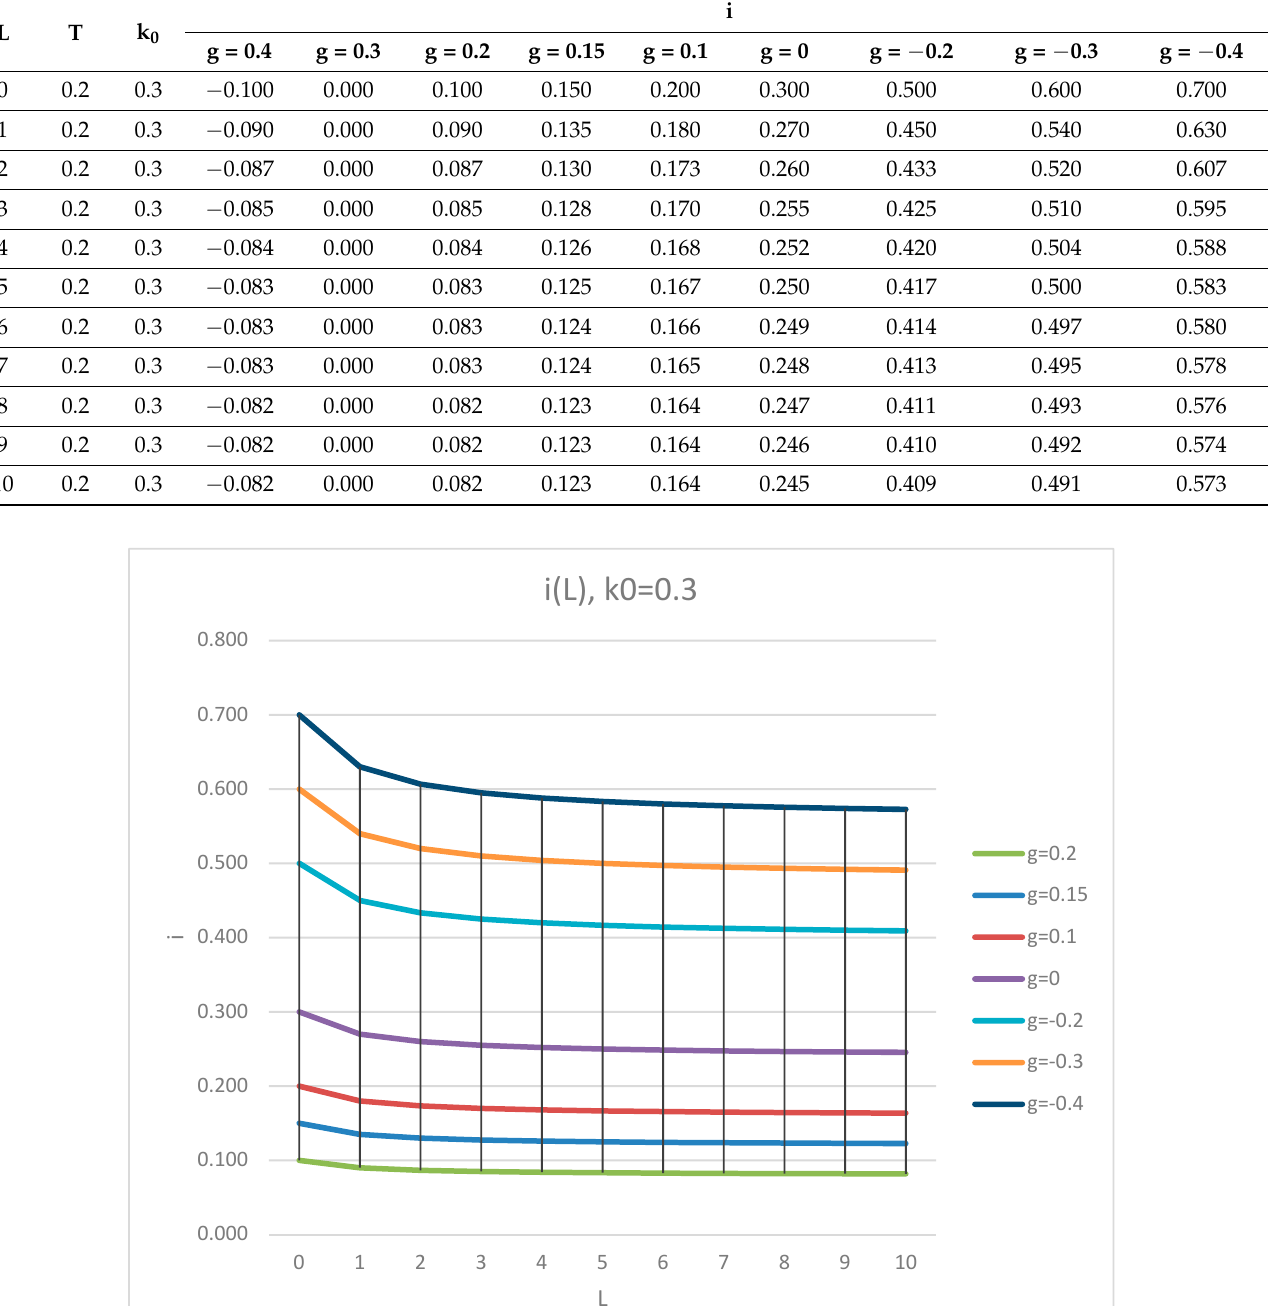
Table 4. Dependence of discount rate i on leverage level L in Generalized Modigliani–Miller theory (GMM theory) at